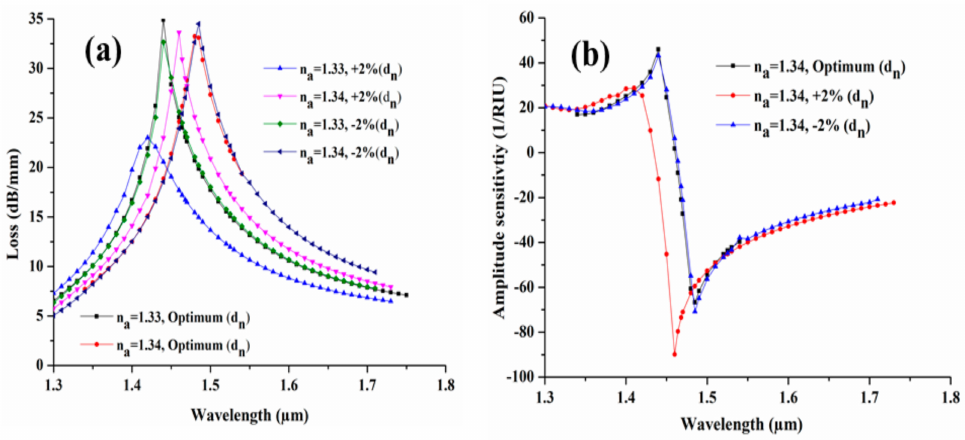
Figure 10. ( a ) Loss spectra and ( b ) amplitude sensitivity, with ± 2% variation in d n of